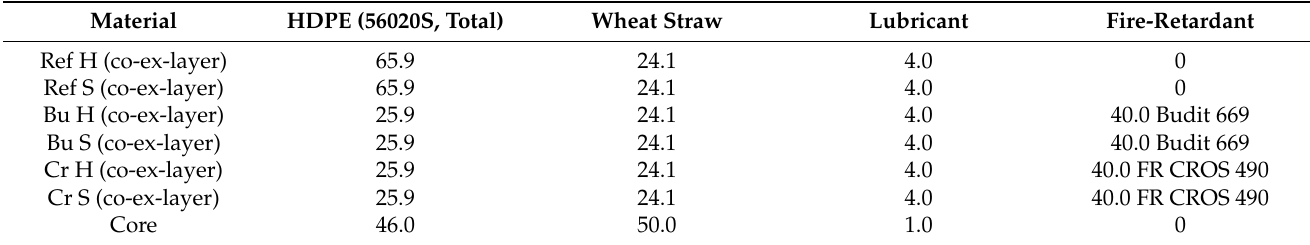
Table 16. Series 1: Composition of formulations for comparison of hollow core (H) and solid (S) profiles. Both types of profiles were co-extruded, with the FR present in the co-extruded layer only. Percentages represent weight-%. In each formulation, 3% of coupling agent (MAPE) was used. In addition, co-extruded formulations contained 4% lubricant; 2.75% pigment masterbatch; 0.25% Irganox B225; 0.1% Tinuvin 326; 0.4% Tinuvin 783; and 0.15% Hycite